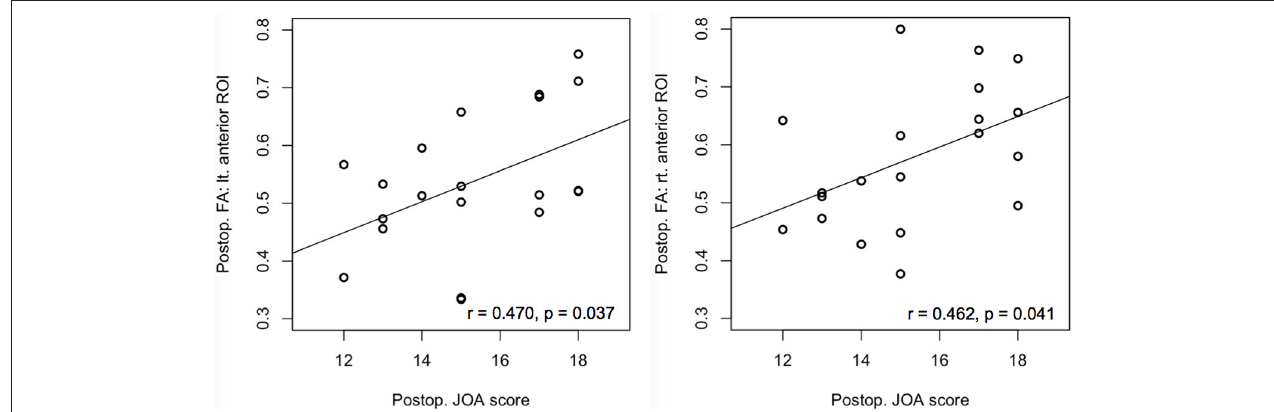
FIGURE 3 | Correlation of the preoperative and postoperative FA values with the preoperative and postoperative mJOA scores at the anterior regions of interest (ROIs) below the lesion level (C7/T1). Significant correlations were observed only between postoperative anterior ROIs with the postoperative mJOA scores. FA, Fractional anisotropy; mJOA, Modified Japanese Orthopedic Association, p <